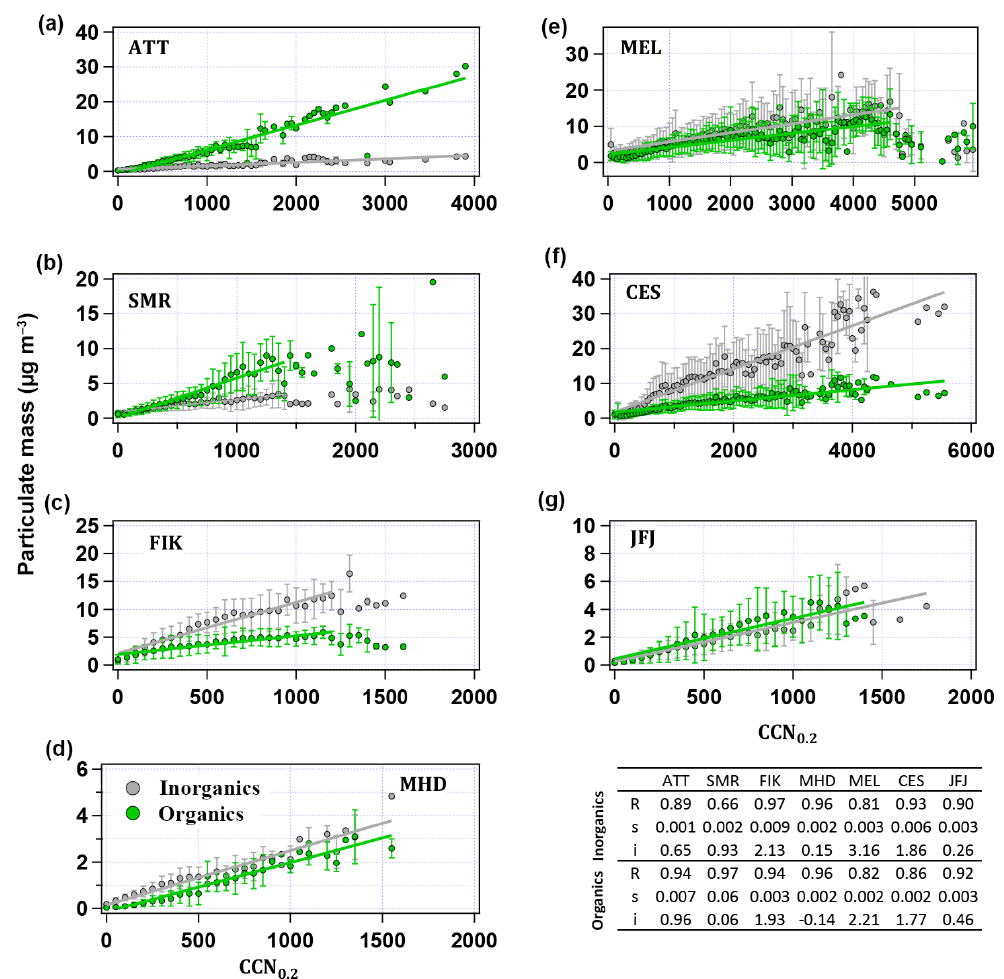
Figure 8. Binned averages and standard deviations of inorganic and organic particle mass concentrations versus CCN 0 . 2 . The mass concen- trations are averaged over bins of 50 particles cm − 3 . Green and grey lines are linear fits through the points with all parameters given in each panel. The table provides the linear regression data: R stands for correlation coefficient, s for slope and i for